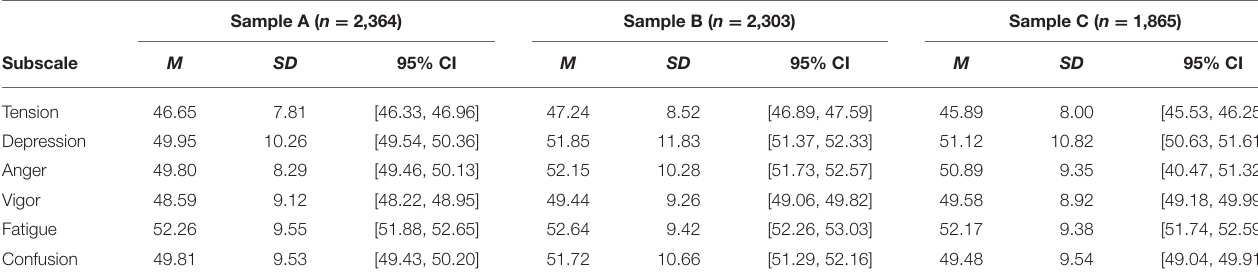
TABLE 2 | Descriptive statistics for BRUMS